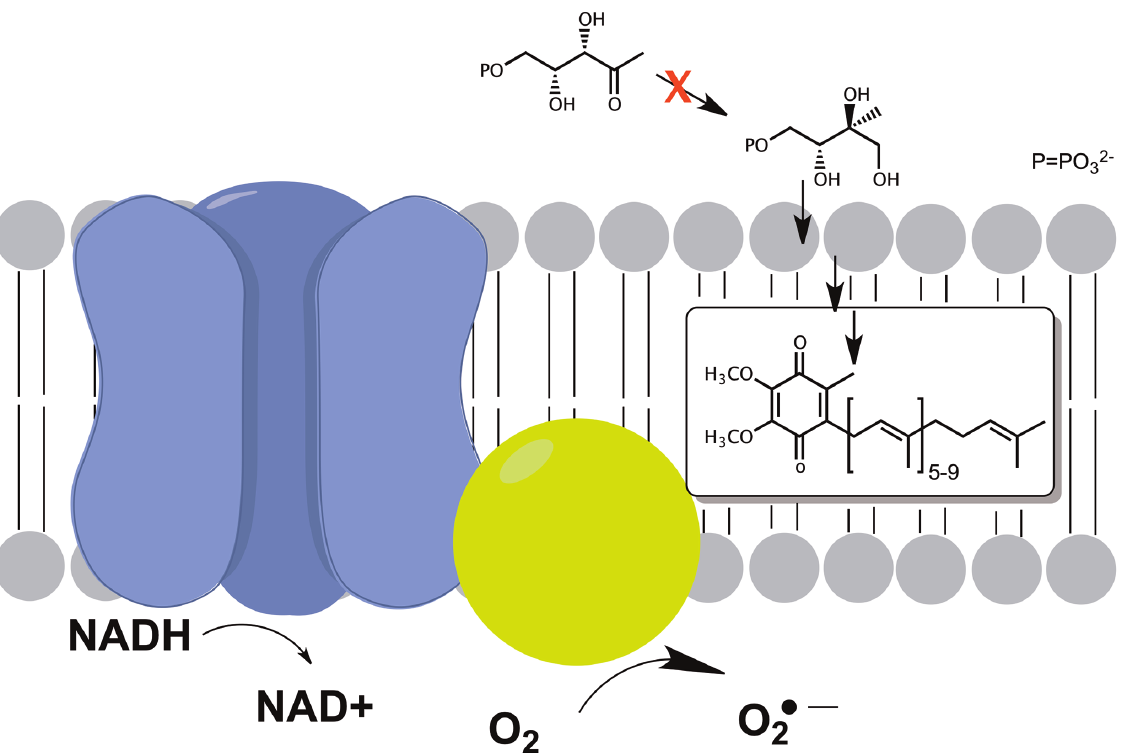
Figure 5. Potential Effects of Isoprenoid Deprivation on Cellular Respiration. Disruption of the MEP pathway reduces the cell’s ability to form late stage isoprenoid products such as ubiquinone and menaquinone. Impairment of bacterial respiration via inhibition of ubiquinone/ menaquinone synthesis may decrease the cell’s ability to reduce oxygen into water, and ultimately may foster the production of reactive oxygen species through direct reduction of molecular